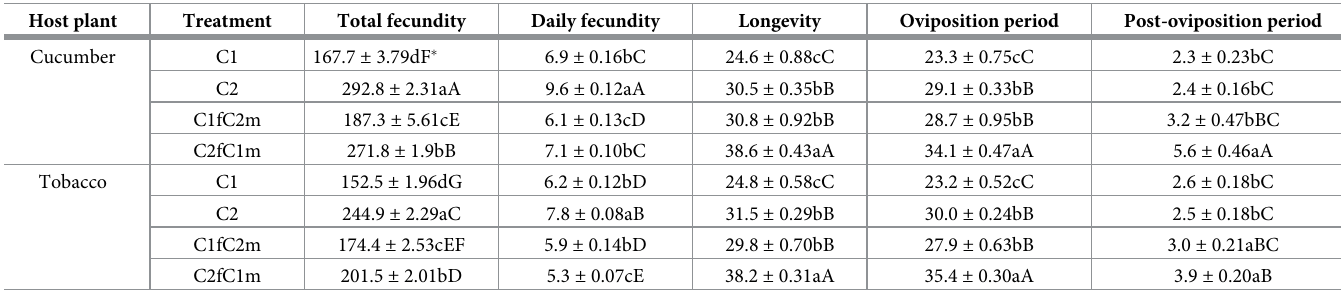
� Means followed by the same letter (lower case letter, comparison among genetic clusters within a host plant; capital case letter, comparison among genetic